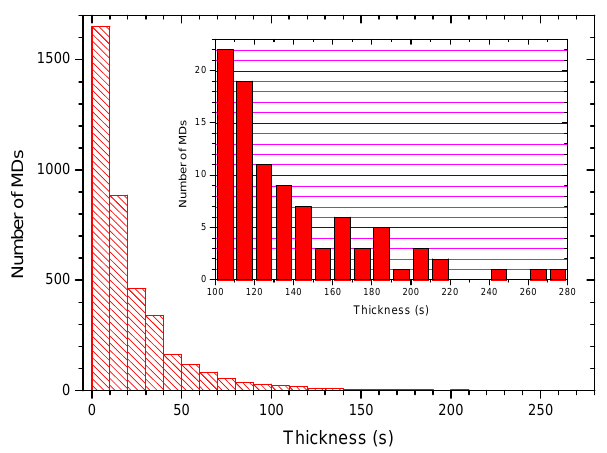
Figure 8 Fig. 8. The (temporal) “thickness” of MDs. The minimum thick- ness is 2–3 ρ p . The maximum thickness extends to hundreds of ρ p .